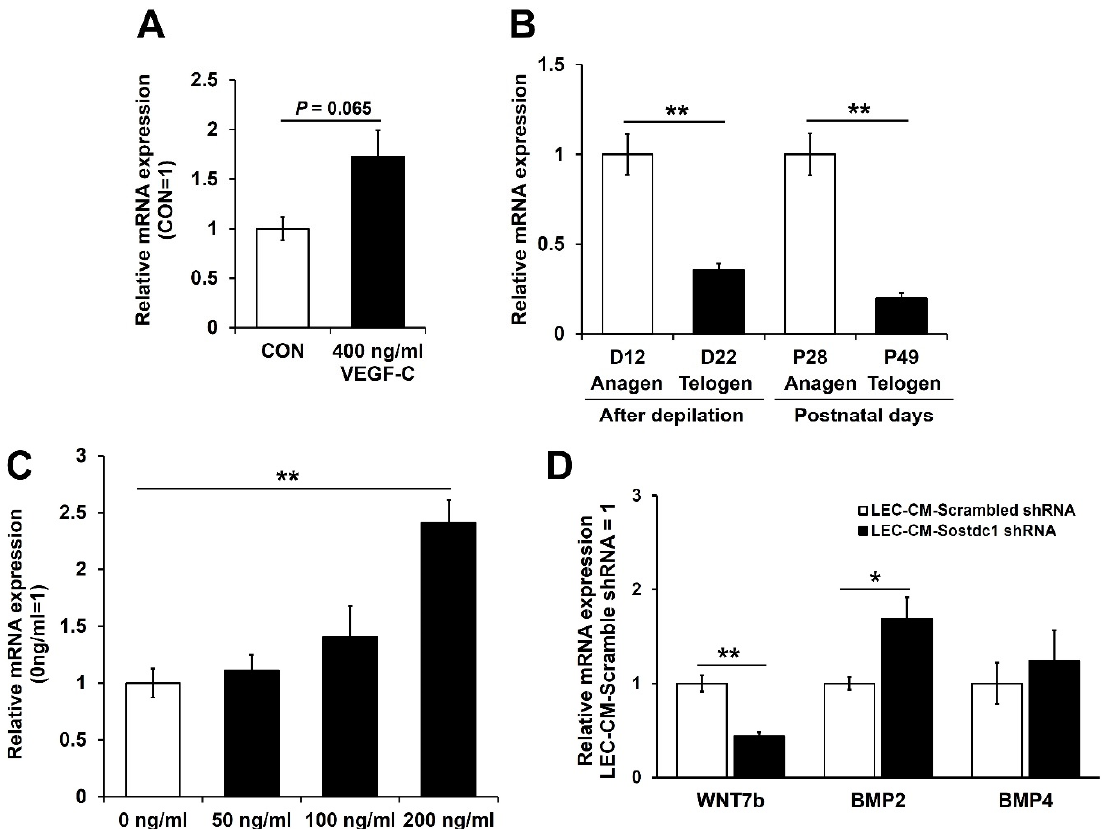
Figure 3. Sostdc1 expression levels were significantly increased during the anagen phase. ( A ) LECs were incubated with 400 ng/mL VEGF-C for 24 h, followed by qRT-PCR to assess Sostdc1 expression. ( B ) Total RNA was isolated from the back skin of female C57BL/6 mice and Sostdc1 expression was determined by qRT-PCR. ( C ) DPCs were treated with the indicated concentrations of Sostdc1 for 72 h and Lef-1 mRNA expression was determined by qRT-PCR. ( D ) DPCs were incubated with 50% LEC-CM-Sostdc1 shRNA or LEC-CM-scrambled shRNA for 48 h. Total RNA was isolated and mRNA expression levels of WNT7b, BMP2 and BMP4 were measured by qRT-PCR. Results are expressed as mean ± SEM. Data were analyzed using a two-tailed unpaired t -test. * p < 0.05, ** p < 0.01 compared to the control group.